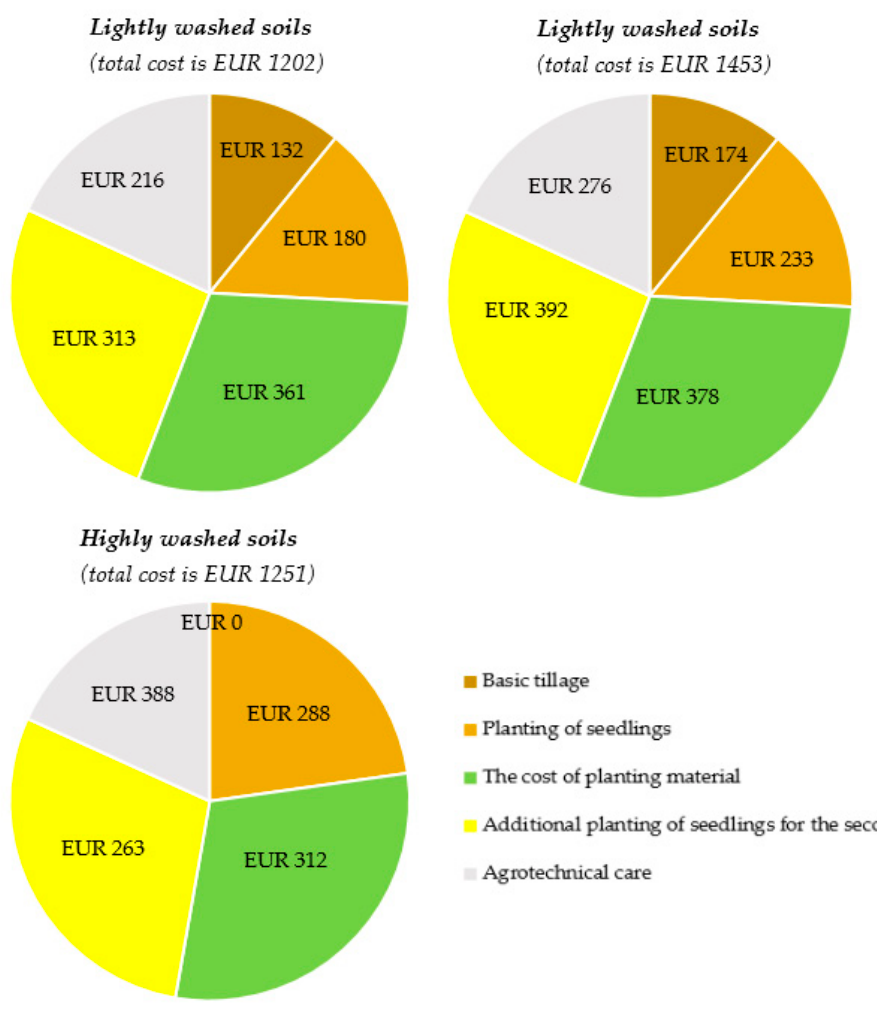
Figure 4. The costs of creating 1 hectare of runoff-regulating forest plantations in arid conditions of the Lower Volga region with a slope steepness of 2.1–6.0°. Table 2. Capital intensity of the arrangement of the sloping agricultural landscape with forest plantations and the simplest hydraulic